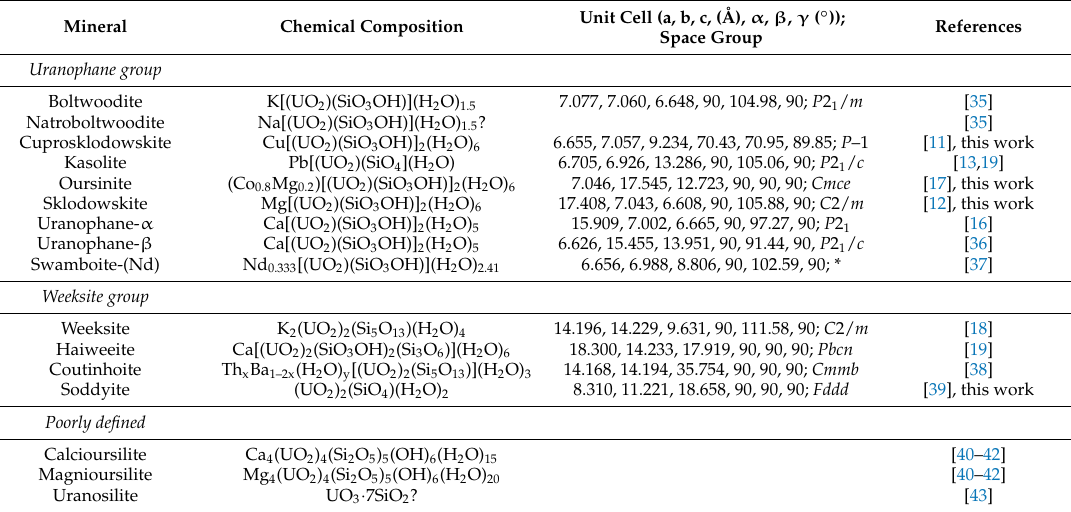
Table 1. Uranyl silicate minerals.